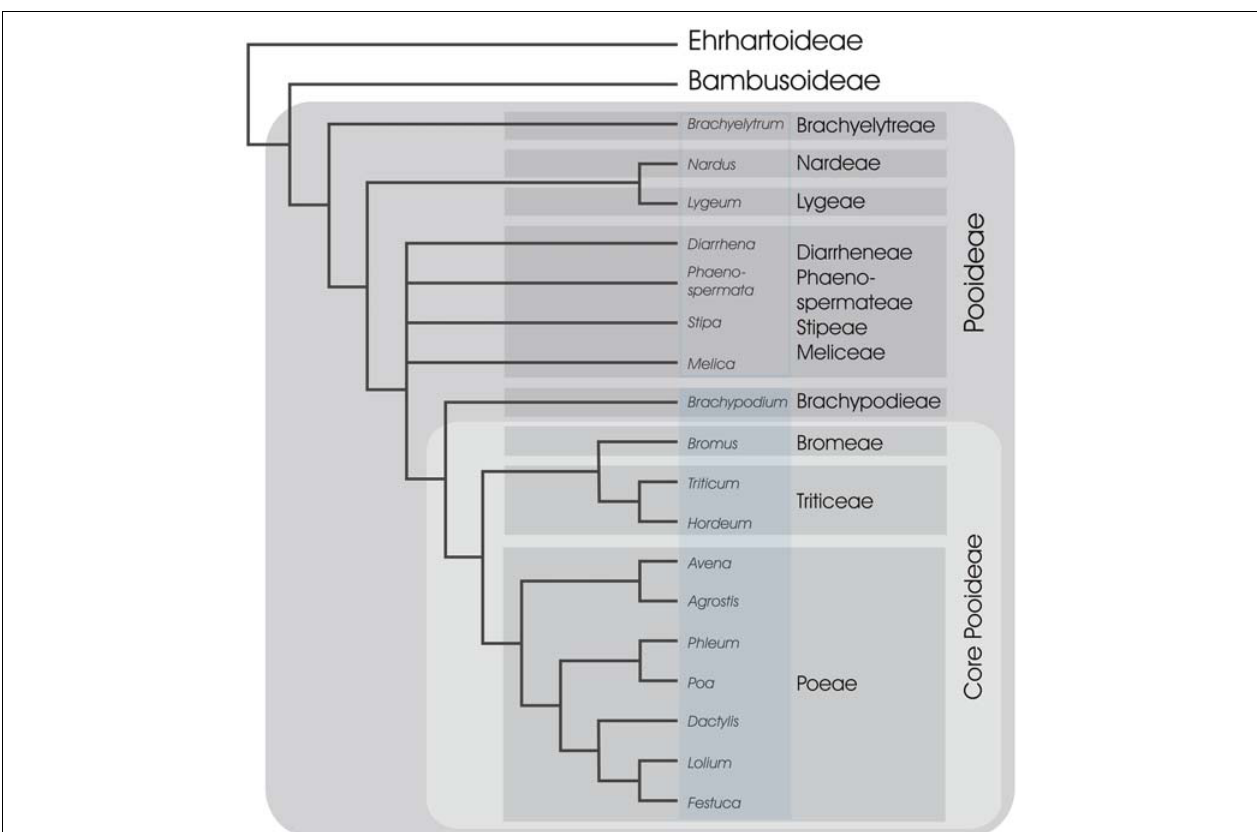
flowering in response to vernalization and long days (shaded blue rectangle; Fejer, 1966; Sampson and Burrows, 1972; Richardson etal., 1986; Heide, 1994; Schwartz etal., 2010), whereas the remaining genera in Pooideae have unknown flowering requirements (open blue rectangle).The two closest non-Pooideae subfamilies (Ehrhartoideae and Bambusoideae) are also shown (BEP